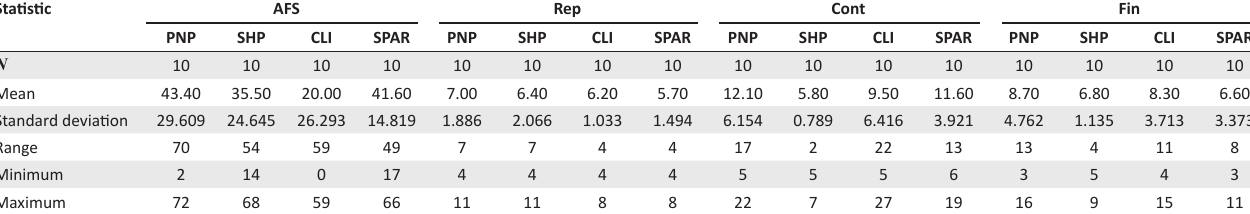
TABLE 4a: Descriptive statistical analyses of page numbers: Pick n Pay, Shoprite, Spar and Clicks. Statistic AFS Rep Cont Fin